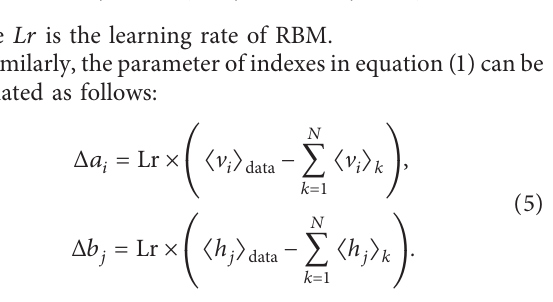
Figure 3: The altitude profile of the road.